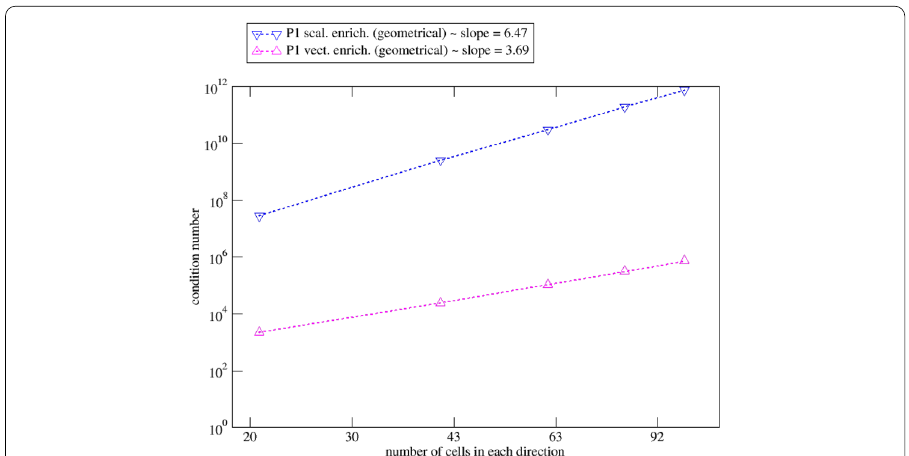
Fig. 21 Conditioning of crack approximations. The condition number increases swiftly with the geometrical enrichment strategy i.e. the introduction of singular functions on many layers of elements around the crack-tip